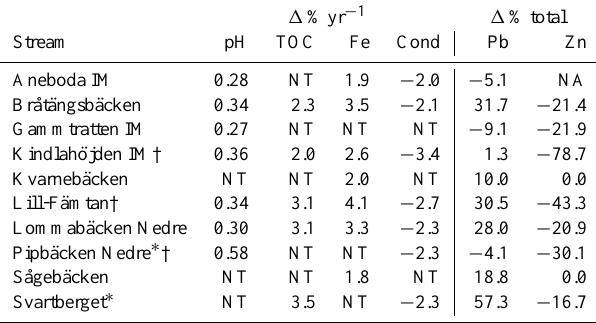
Table 6. Predicted changes ( 1 % total) in Pb and Zn during the next 20yr based on previous long-term trends (1996–2009, Huser et al., 2011) for common model variables (pH, TOC, Fe, and Cond), shown as % change per year (% 1 yr − 1 ). TOC was used as a proxy for AbsF. Aneboda IM was excluded from Zn analysis (NA) due to low model power. NT = no significant trend detected. 1 %yr − 1 1 %total Stream TOC